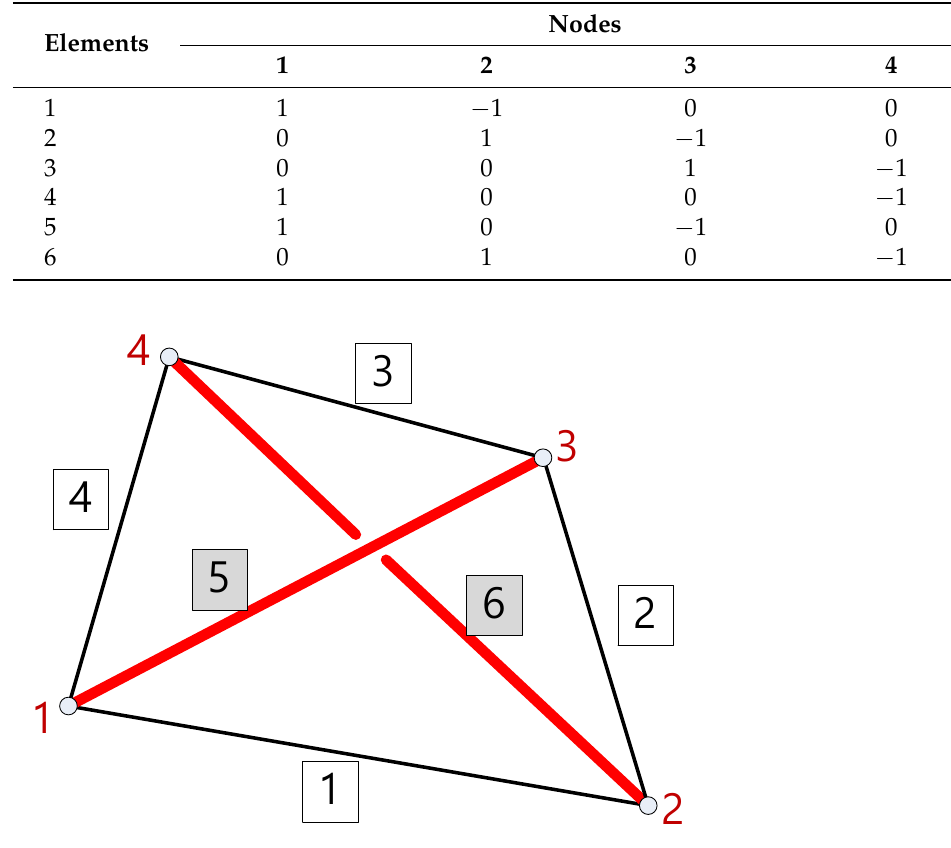
Figure 2. A 2D two-strut tensegrity structure in which cables and struts are denoted by the thin and thick